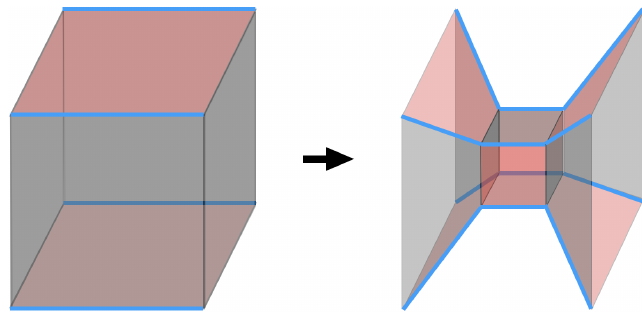
Figure 14 . Local transformation of the quiver under triality for a node with n χ initial configuration is the dual quiver of the cylindrical in Figure 13.